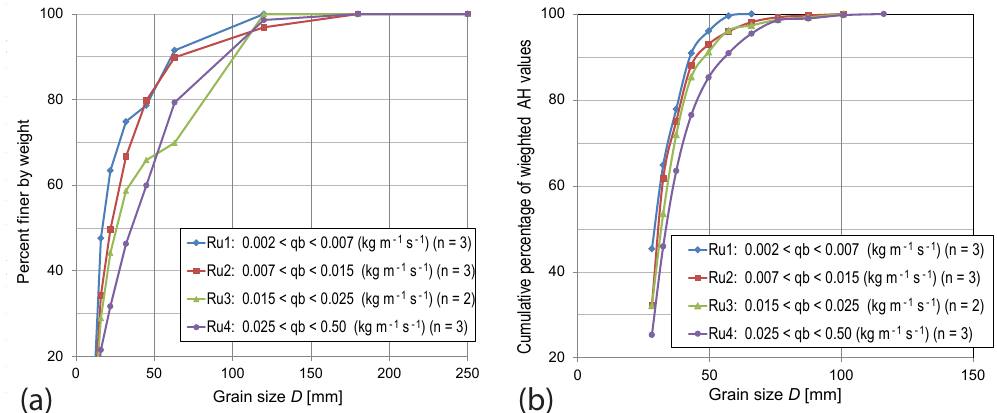
Figure 12. Ruetz: (a) grain size distributions derived from the calibration bedload samples (for D > 10mm), averaged for four classes of bedload fluxes q b (using 11 samples from 2010–2013); (b) relative distribution of grain sizes estimated from the geophone measurements based on the AH data, averaged for the same four classes of bedload fluxes (using the same 11 sample periods from 2010 to 2013).